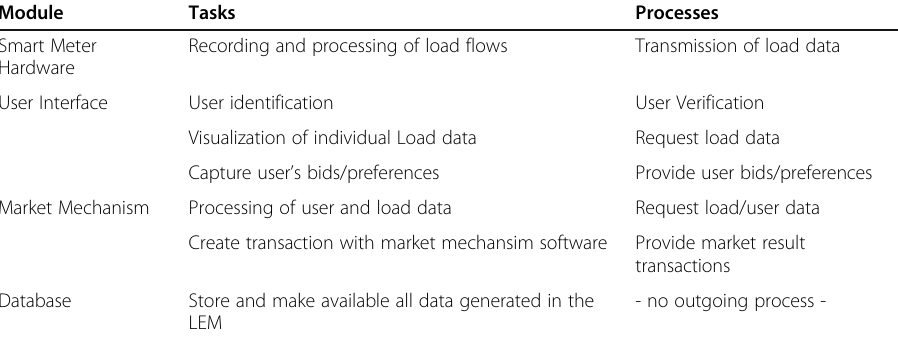
Table 1 IT-architecture modules, tasks and processes Module